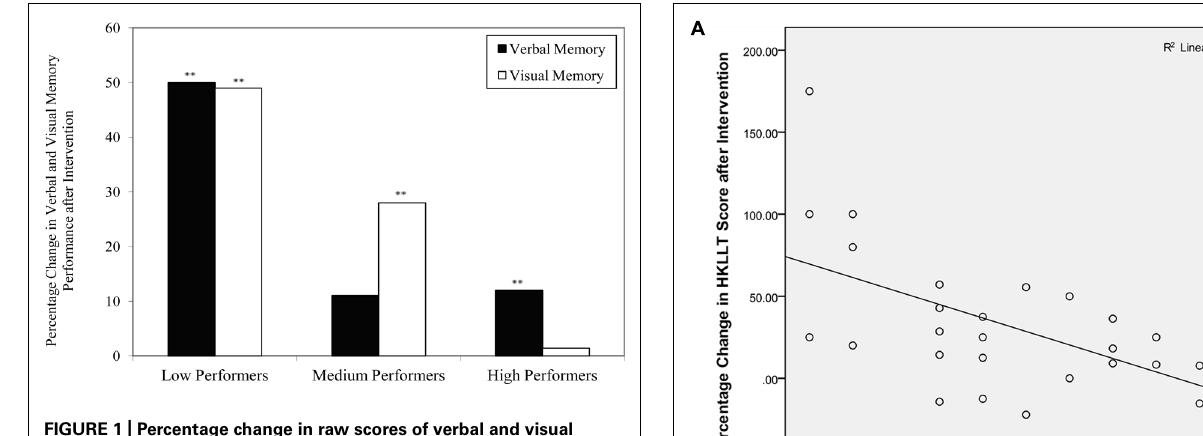
FIGURE 1 | Percentage change in raw scores of verbal and visual memory tests across three levels of performance subgroups after intervention. ** p < 0.01 in paired samples t -test (one-tailed).